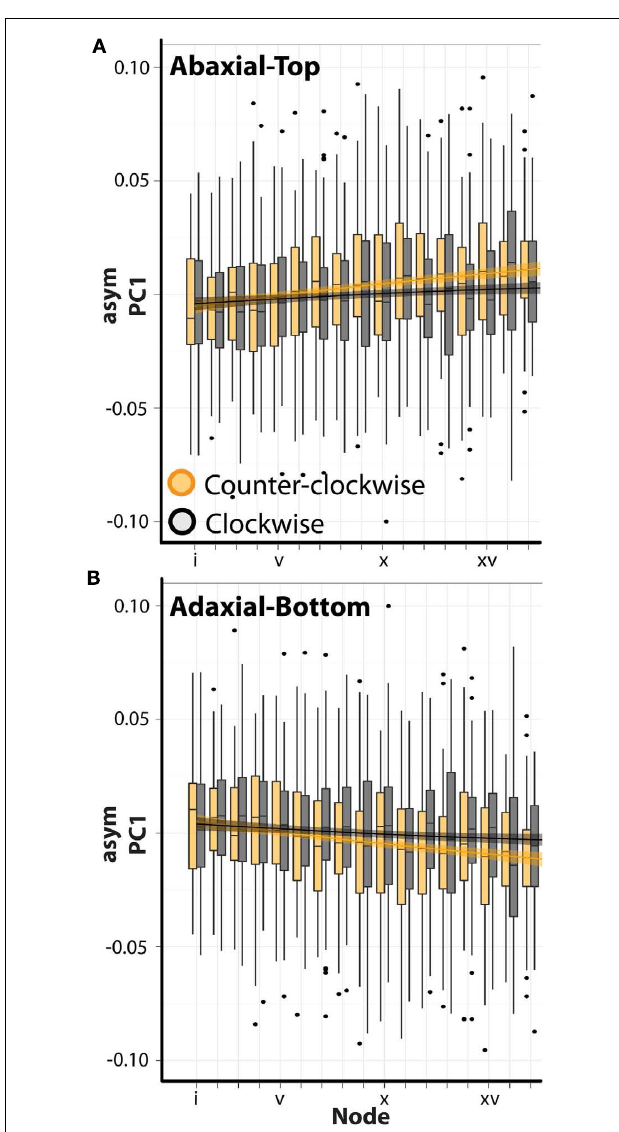
FIGURE 5 | Leaves arising from plants with opposing phyllotactic directions possess different degrees of asymmetry. (A) asymPC1 values for abaxial-top images separated by leaves arising from clockwise (gray, CL) and counter-clockwise (orange, CC) plants. Note the more extreme asymmetry exhibited by leaves from CC plants. x -axis shows node position (lower values closer to the apex). Superimposed upon barplots are loess regression lines with standard error bands. (B) The same as shown in (A) , except for adaxial-bottom images. Note that the values are mirror images of those shown in (A) , as the adaxial-bottom image of a leaf is the mirror of the abaxial-top image. Again, leaves arising from counter-clockwise plants exhibit more extreme